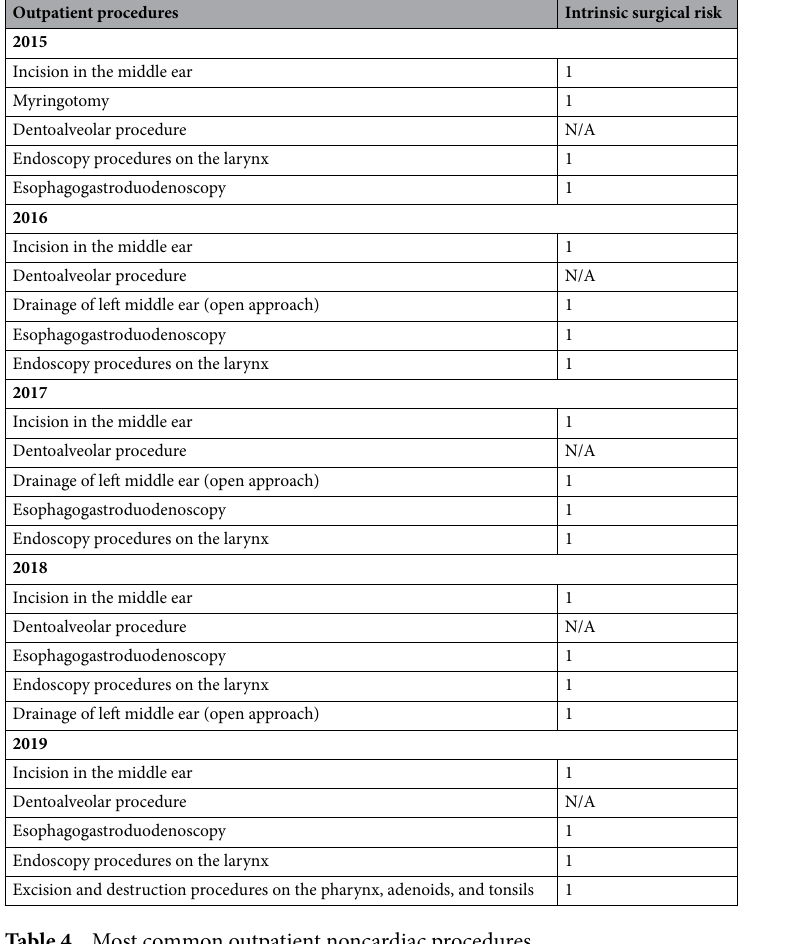
Table 4. Most common outpatient noncardiac